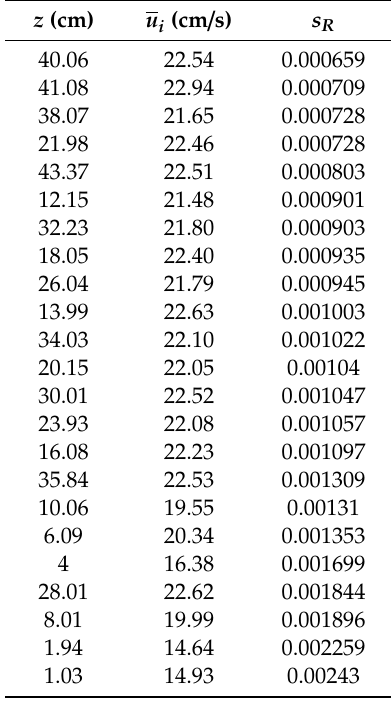
Table A1. Random standard uncertainties in velocity